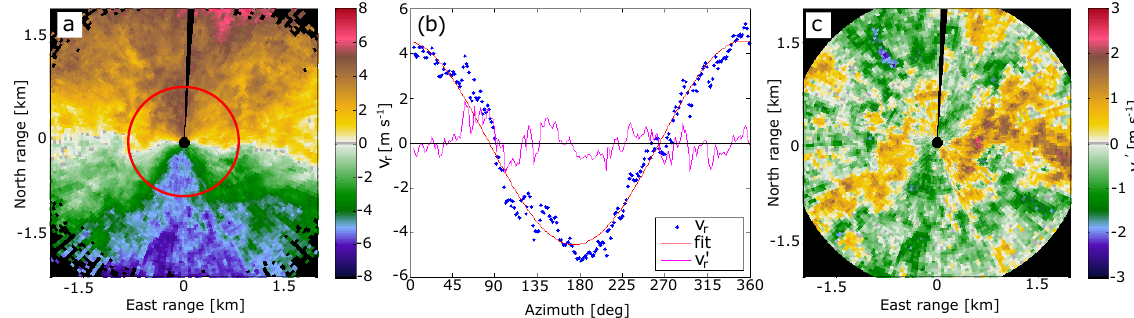
Figure 1. Sample PPI scan (a) during a turbulent time period, with the VAD fitting and its residuals to v r observations at the range ring denoted by the red circle shown in (b) . Turbulence structures can be visualized in the residuals across the entire scan (c)